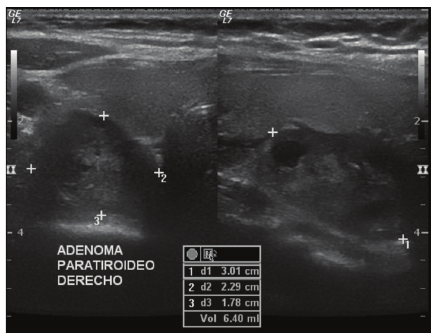
Figure 3: Right inferior parathyroid gland